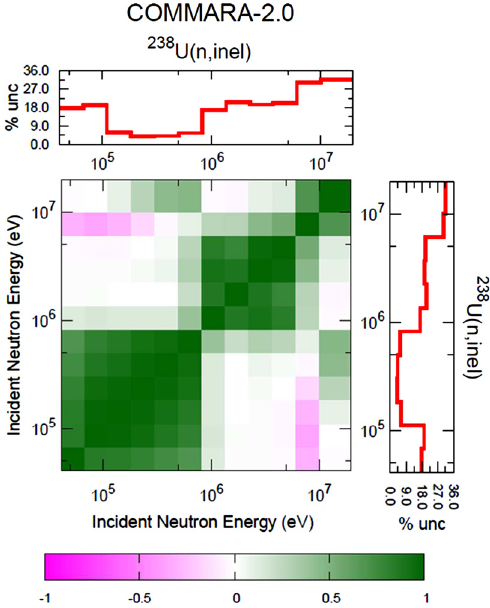
Fig. 4. 238 U inelastic uncertainty and energy correlation: COMMARA-2.0.